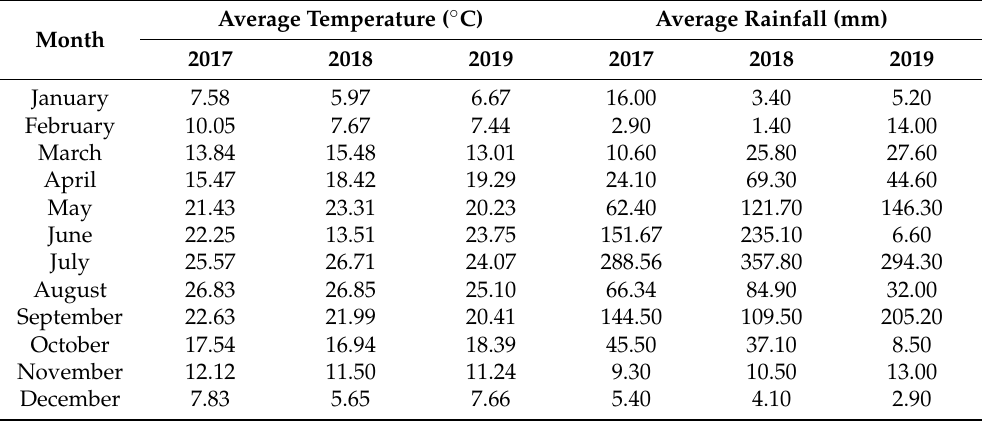
Table 1. Monthly average temperature and rainfall of experimental site from year 2017 to